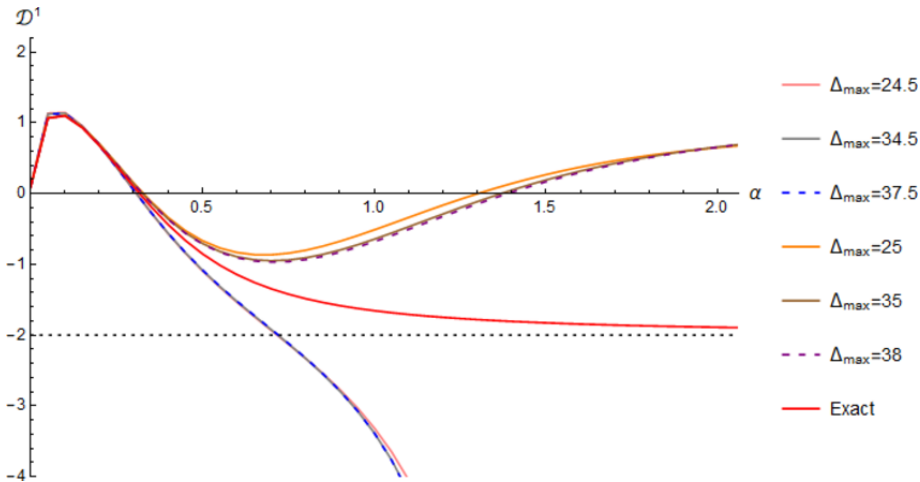
Figure 4. D 1 ( e 1 (cid:0) e 0 ) versus (cid:11) > 0 for the free spectator. Linear term removed using interaction s matrix